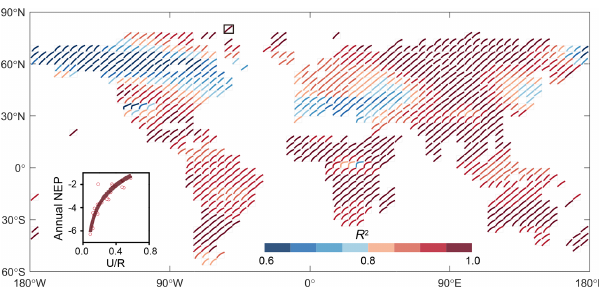
Figure 2. Relationship between annual NEP and U /R for the Jena CarboScope inversion product (of the form NEP = β · ln ( U black box indicates the location of the